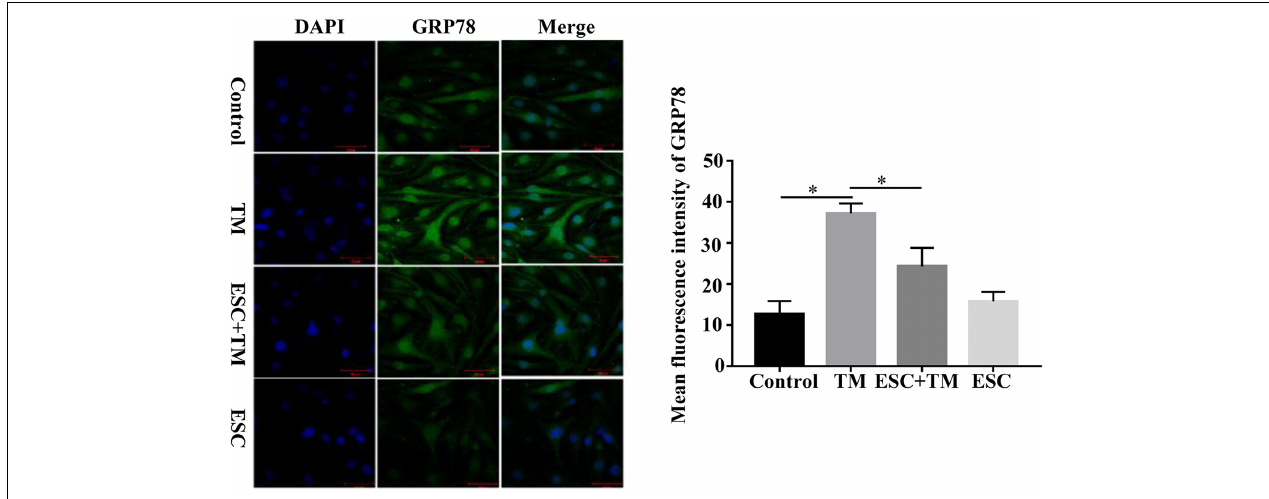
FIGURE 3 | Effect of escitalopram (ESC) on GRP78 expression in bEnd.3 cells. GRP78 expression was measured by immunofluorescence microscopy (400 × ). The mean fluorescence intensity was computed by using ImageJ (v1.8.0.112). Results were shown as the mean ± SD. * p <